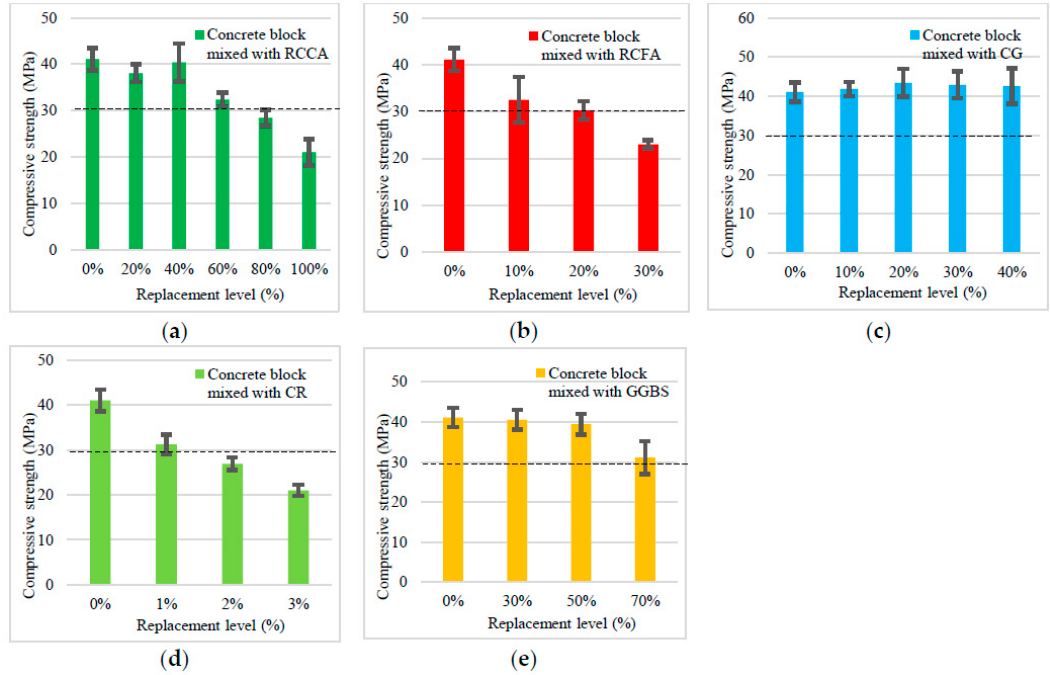
Figure 8. Relationship between the different replacement levels of materials and the compressive strength of specimens.